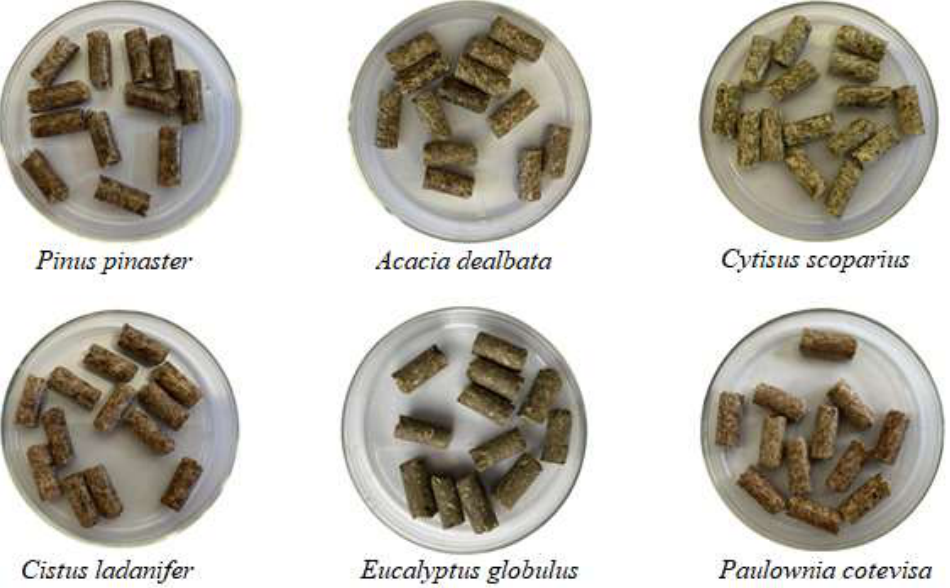
Figure 1. Photographs of the tested pellets. In addition to pellet dimensions, the average pellet density, moisture content and volatile content of the pellets were also determined. The pellet density was determined by the method of dimensions [25]. This method is based on the relationship between the mass of a pellet and the corresponding volume, considering it as a cylinder. Table 1 shows the average dimensions (length and diameter), the mass and the density of the pellets used in the ignition tests. Table 1. Dimensions, mass and density of the experimental pellets.